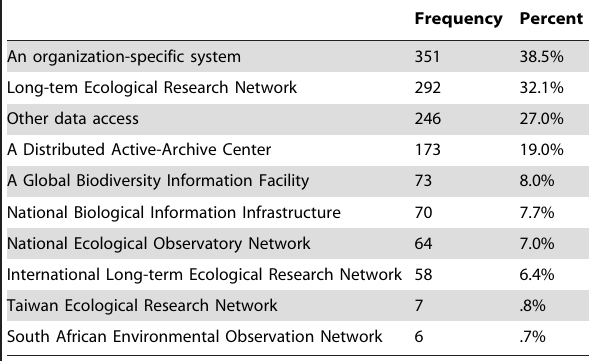
Table 3. Data access.